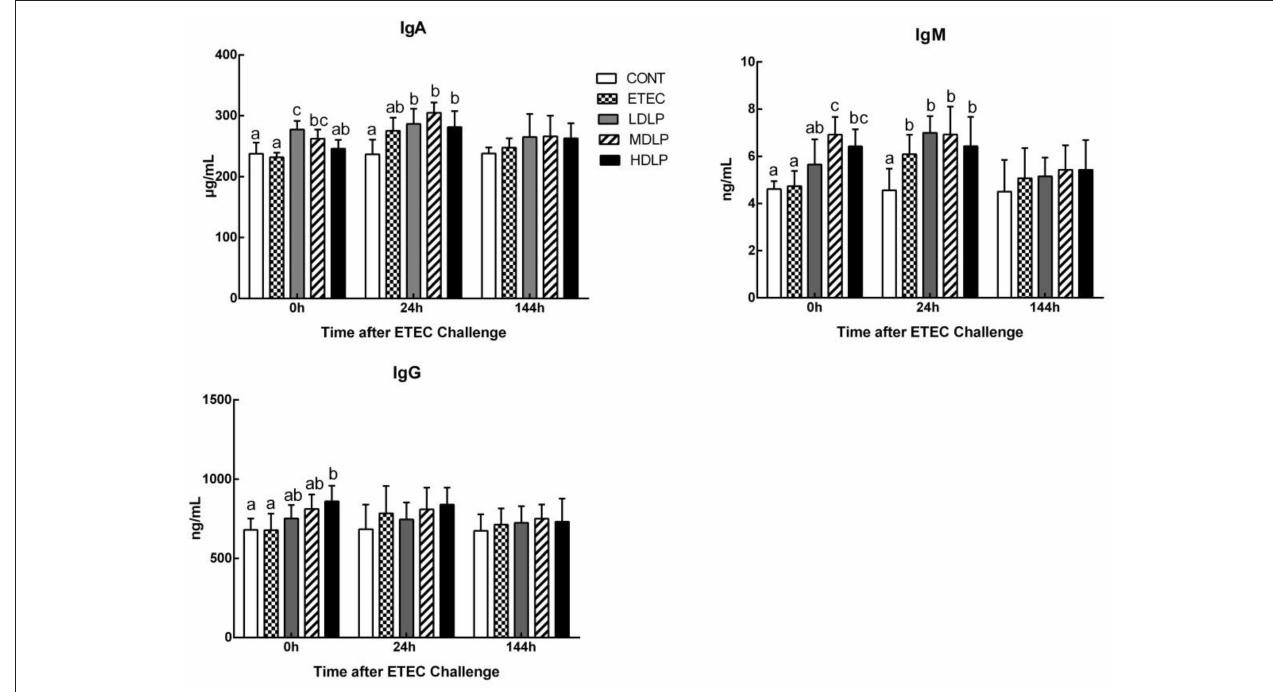
FIGURE 4 | Dose effect of Lactobacillus plantarum on concentrations of IgA, IgM and IgG in serum of mice during pre- and post-challenge periods. CONT, control group, treatment with PBS at all period; ETEC, negative group, oral challenge with ETEC on day 15; LDLP, low dose (5.0 × 10 8 cfu mL − 1 ) group; MDLP,